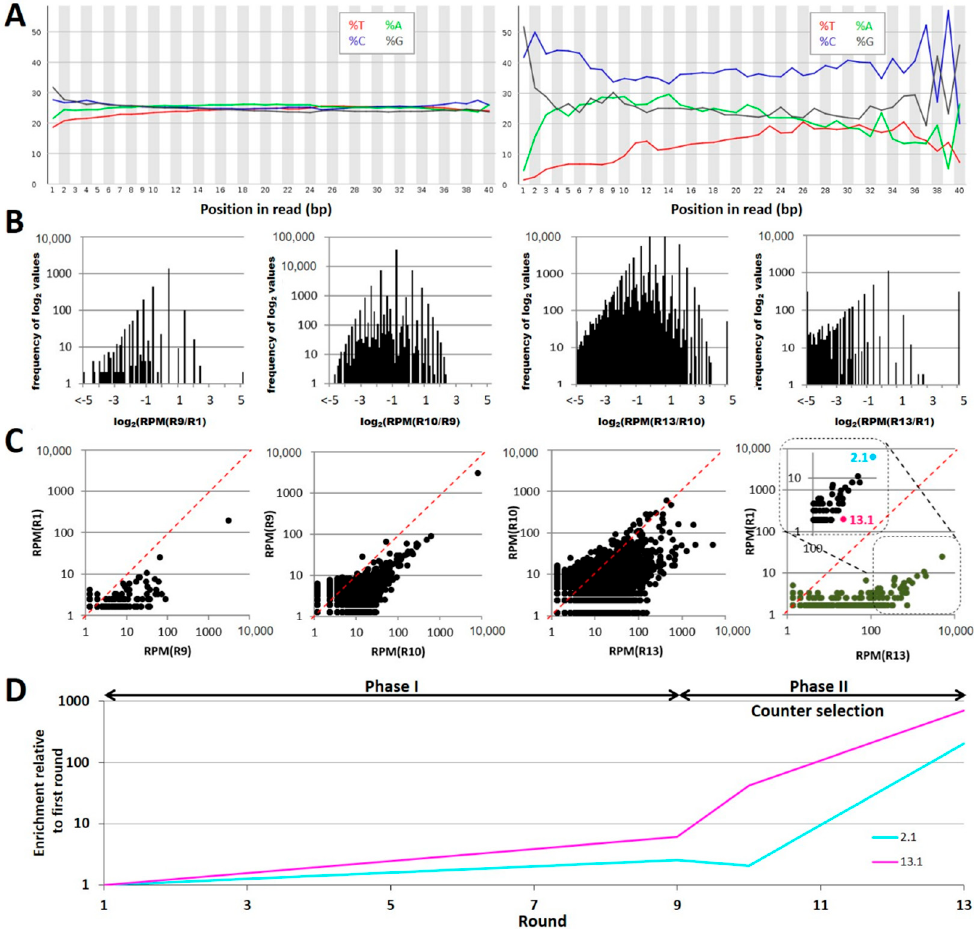
Figure 3. Bioinformatic analysis of the sequenced polyclonal aptamer library shows enrichment of individual aptamer sequences ( A ) Nucleotide distribution of the library R1 (left panel) and library R13 (right panel). The distribution of each nucleobase is given as a percentage; red lines indicate thymine (T), blue lines cytosine (C), green lines adenine (A), and grey lines cytosine (C). ( B ) Histogram of the relation of enrichment and depletion of individual sequences in different rounds. From left to right R1/R9, R9/R10, R10/R13, R1/R13. The histograms show significant depletion of individual sequences (log 2 < 0) compared with progressing SELEX rounds. ( C ) Scatter plot comparing the sequences from rounds R1/R9, R9/R10, R10/R13, R1/R13 (left to right) shows an enrichment of individual sequences with increasing SELEX round numbers. The red lines represent an unchanged sequence distribution between the rounds. In the right scatter plot, the most enriched and the most abundant sequence were highlighted and chosen for further evaluation. ( D ) Enrichment profile of the sequences AKK13.1 and Akk2.1 during the SELEX process. Both Akk13.1 and Akk2.1 shows a slight enrichment in Phase I (increasing stringency of washing). In Phase II a counter-selection with B. producta was introduced resulting in a massive enrichment of AKK13.1 and